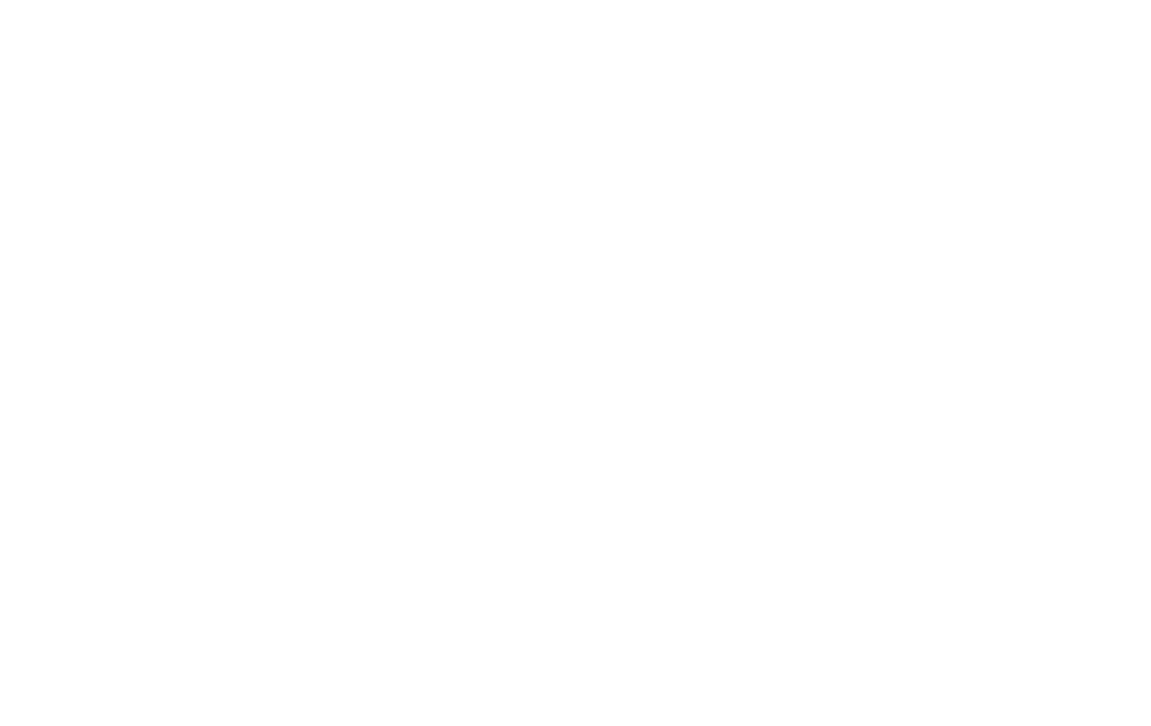
Fig 1. Bland-Altman plots for estimated and measured glomerular filtration rate (GFR) in HIV-positive participants using the CKD-EPI equations for serum creatinine (A), cystatin C (B), or both biomarkers (C). The average GFR (measured and estimated) is shown on the X axes. Bias, defined as the difference between estimated and measured GFR, is displayed on the Y axes. The average biases are represented by the horizontal solid lines and the horizontal dashed lines represent 2 standard deviations above and below the averages.